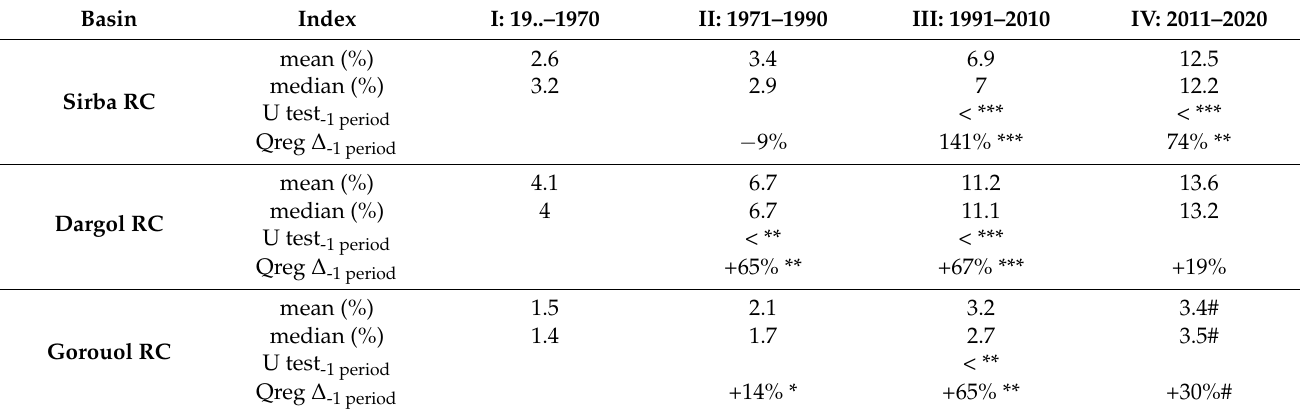
Table 10. Data series segmentation (fixed periods): mean, median and difference of RC of the main Sahelian tributaries. For non-normal distributed variables, the Wilcoxon–Mann–Whitney test (U-test) and the quantile regression (Qreg) were used. The ∆ -1 period is the difference (%) between the period and the previous ones. Significance of changes: *** p < 0.01, ** p < 0.05, * p < 0.1. (#the flow time series of Gorouol stops in